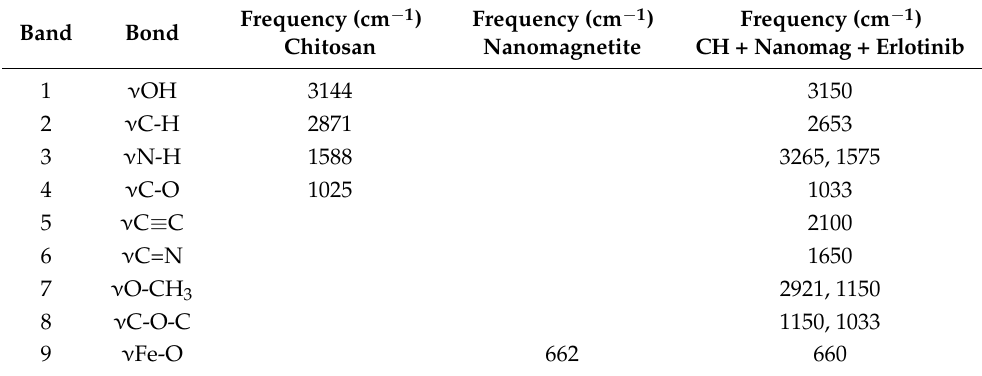
Table 3. FTIR bands